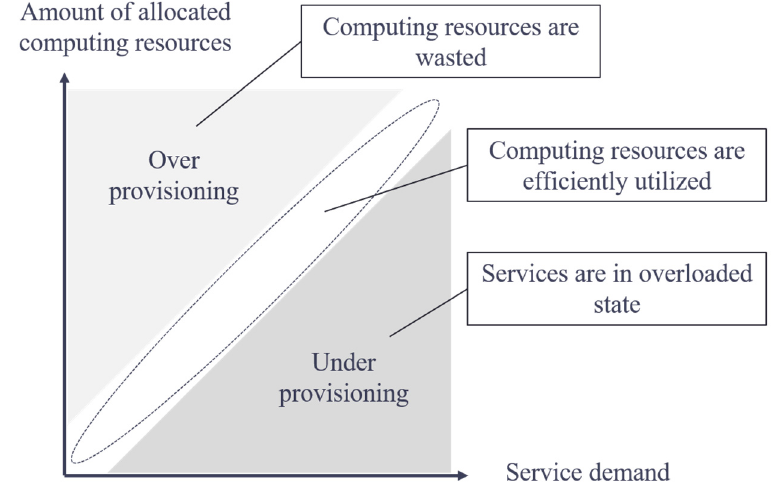
Figure 1. Resource management of cloud-hosted services.